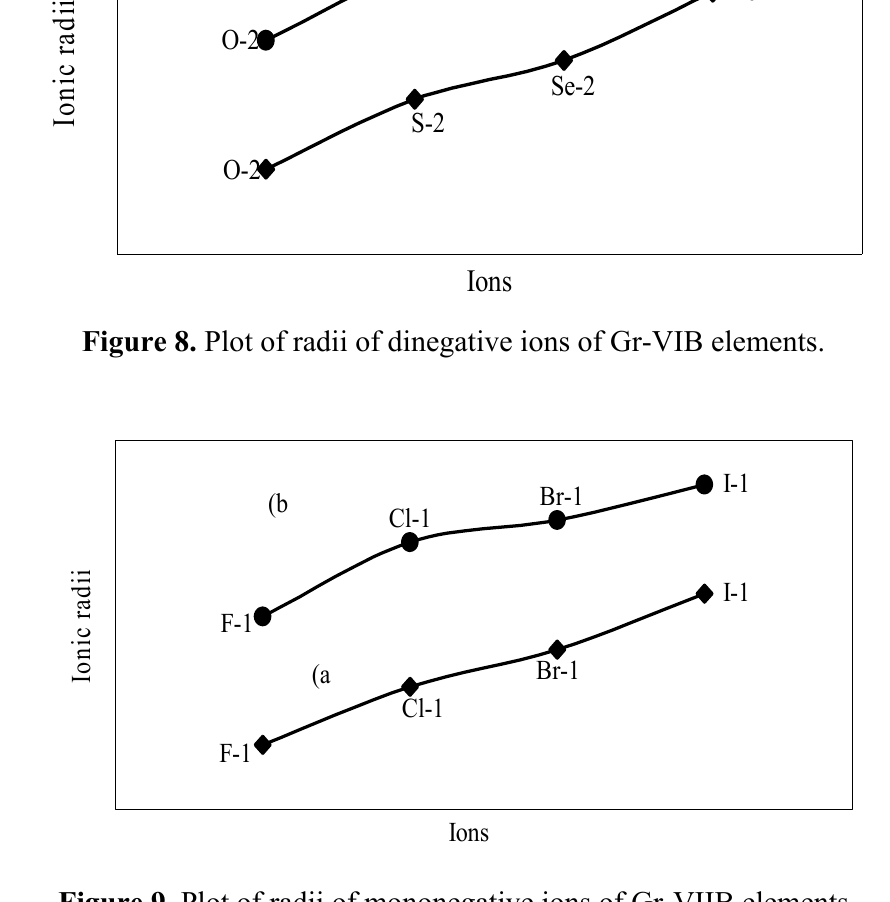
Figure 9. Plot of radii of mononegative ions of Gr-VIIB